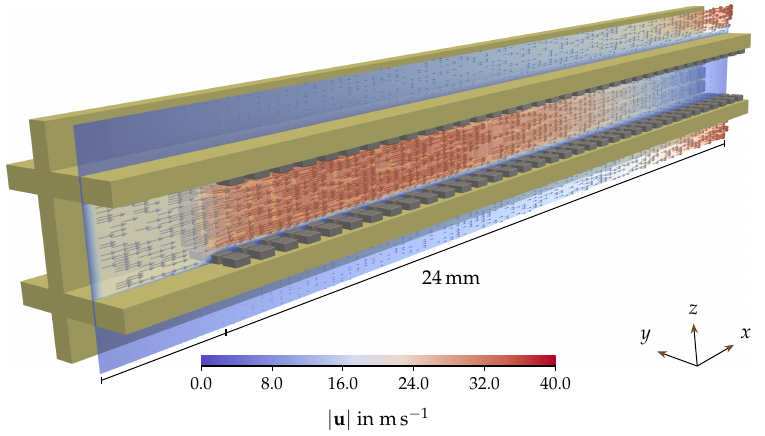
Figure 30. Flow field with fragmented PM layer assuming partial detachment over a relative channel length of x rel = 0.1 in gray. Dark yellow structures represent porous filter substrate. Colour scale indicates local velocity